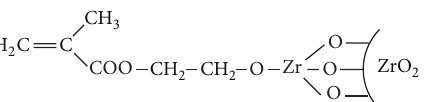
Figure 4: Zirconium oxide nanoparticles functionalized with meth- acryl zirconate.